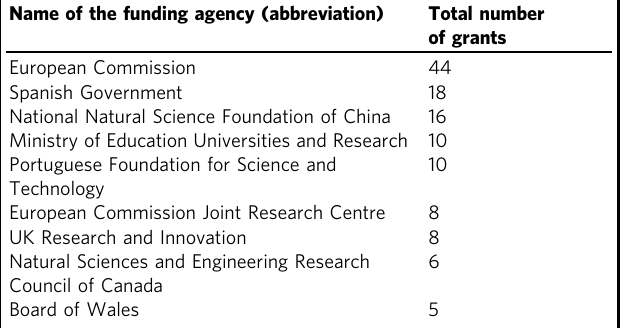
Table 5 Funders of HBIM